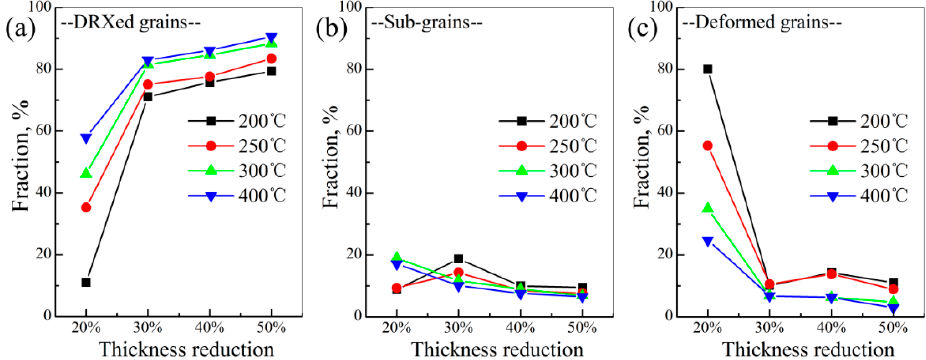
Figure 6. Fraction variation of DRXed grains ( a ), subgrains ( b ), and deformed grains ( c ) under different rolling process parameters.